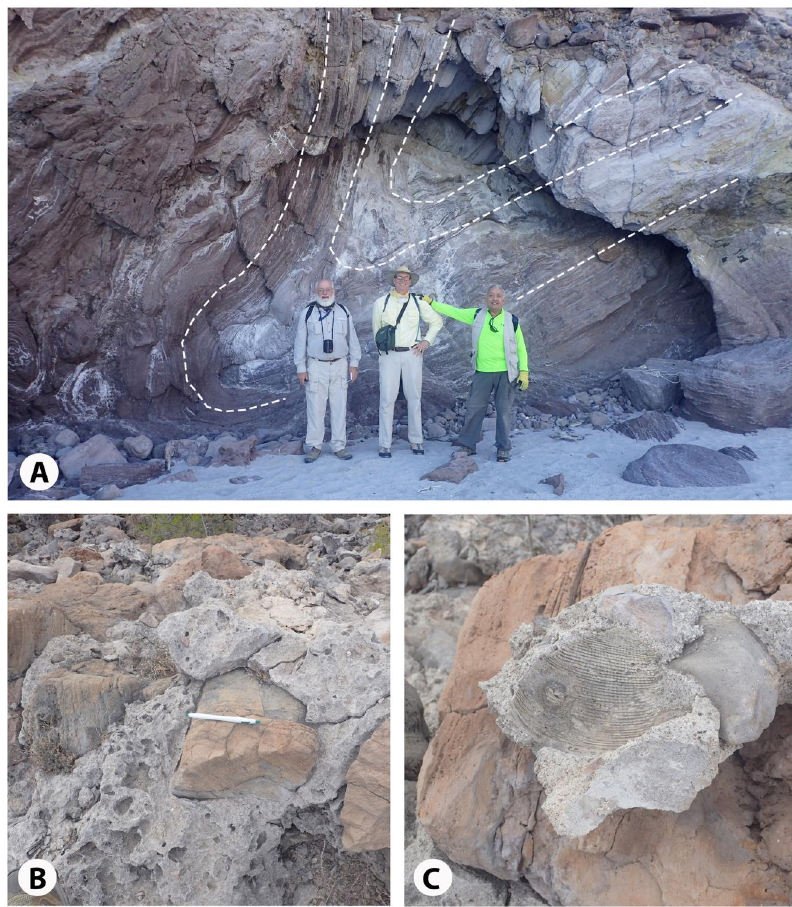
Figure 7. Details from the east side of Ensenada Almeja: ( A ) Banded rhyolite at the shore (figures for scale), ( B ) Basal conglomerate composed of eroded rhyolite cobbles in a limestone matrix (pen = 12 cm), ( C ) Loose piece of conglomerate with external mold of a large bivalve ( Periglypta multicostata preserved in the limestone matrix.